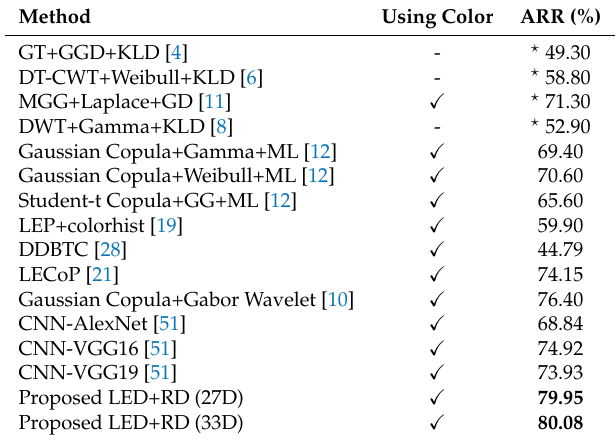
Table 4. Average retrieval rate (ARR) on Stex-7616 database by the proposed method compared to the state-of-the-art